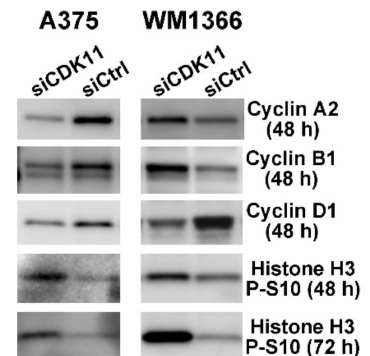
Figure 5. Immunoblot analyses for cell cycle-related proteins following siRNA-mediated down-regulation of CDK11 in melanoma cells. Immunoblot analysis of A375 and WM1366 cell lysates following 30 nM siRNA transfection. SiRNAs transfected are indicated above the blots, proteins detected and time point are indicated on the right side of the blots. CDK11 p110 knockdown verification is indicated in Table 5. Actin signal was used as the loading control.